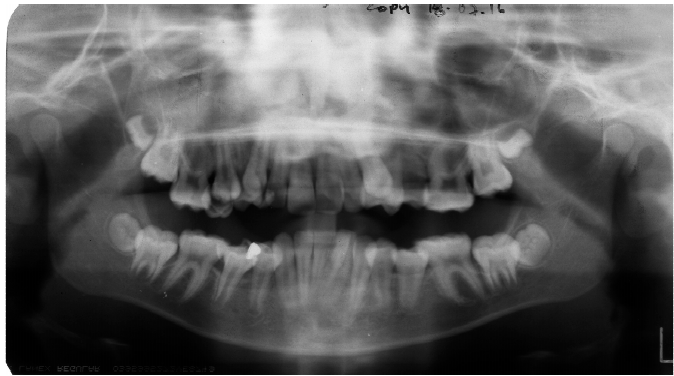
Figure 1. A dental orthopantomogram (OPT) of patient aged 11 years.